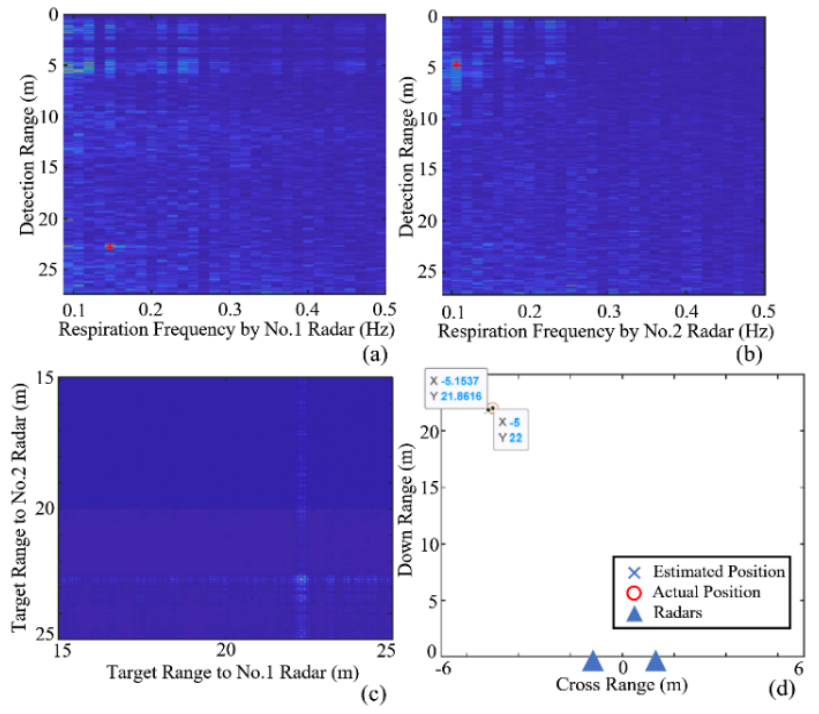
Figure 15. The experiment C result. ( a , b ) The output range-frequency images using the normal FFT-based respiration detection methods using the echoes from a single radar. ( c ) The output two-dimensional (2D) slice (range × range) image for the specific respiration frequency. ( d ) The positioning result calculated by the radar system is compared with the actual position of the person.